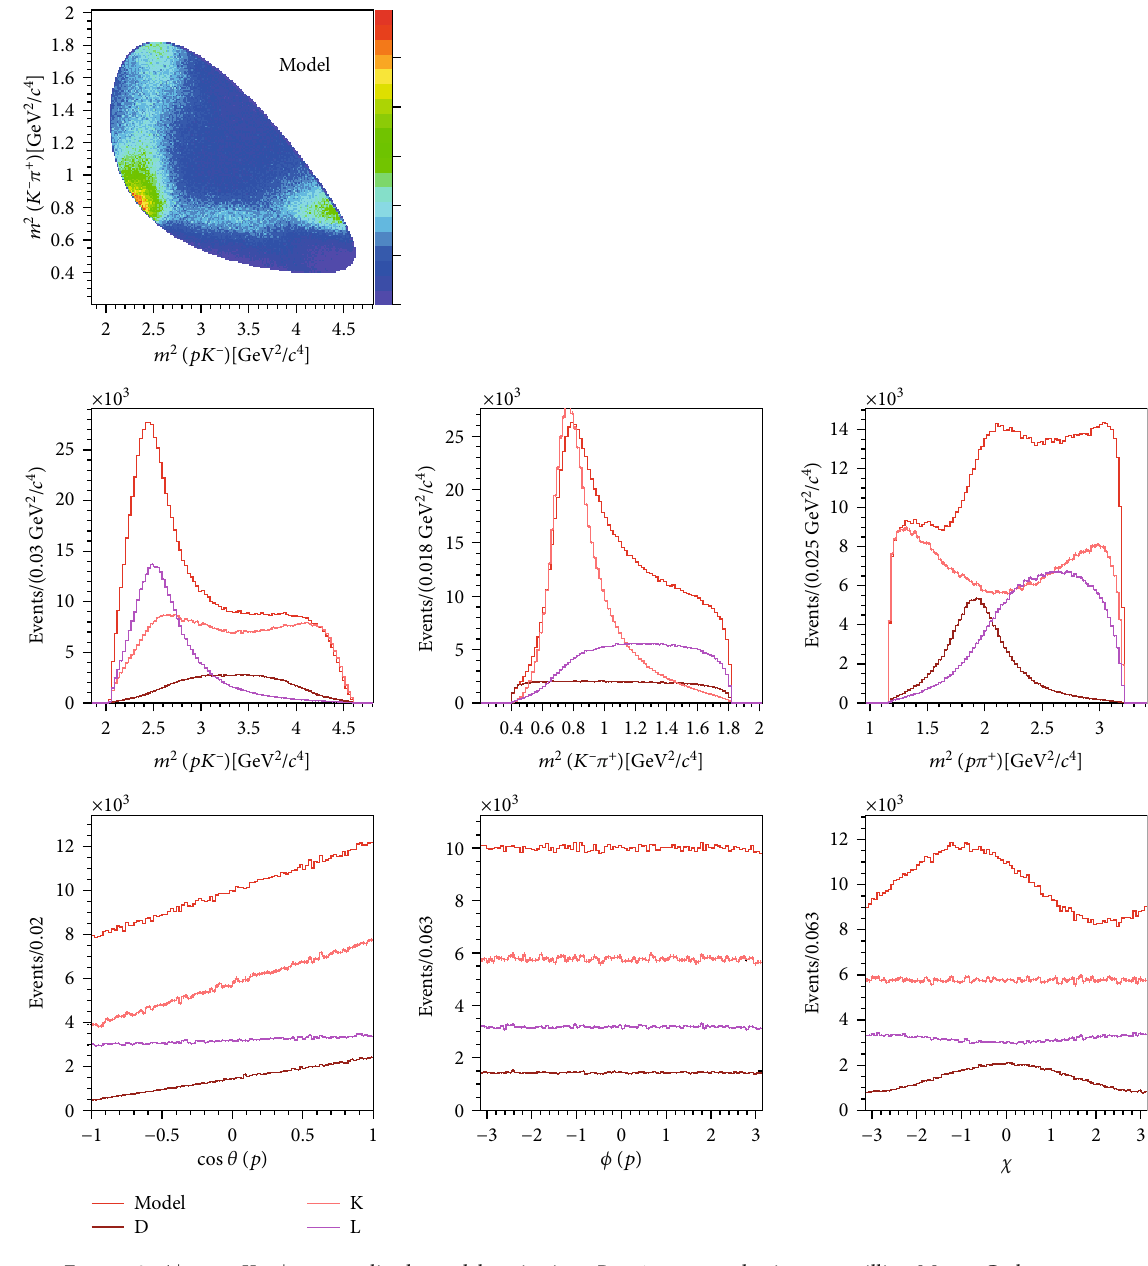
= 1 , generated using one million Monte Carlo z